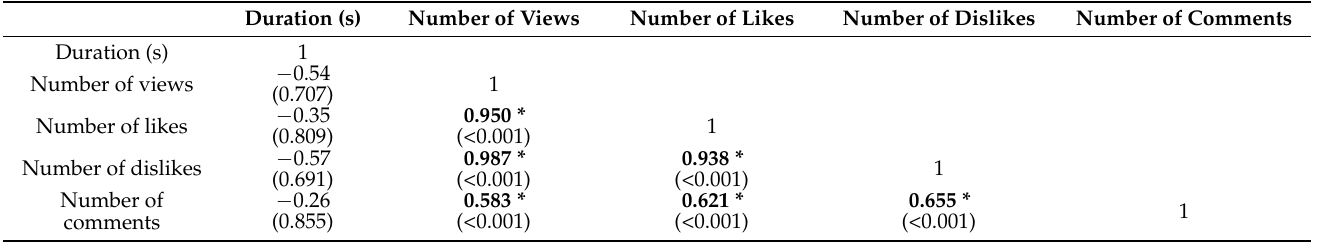
Table 2. Pearson‘s correlations among the general features of the videos.